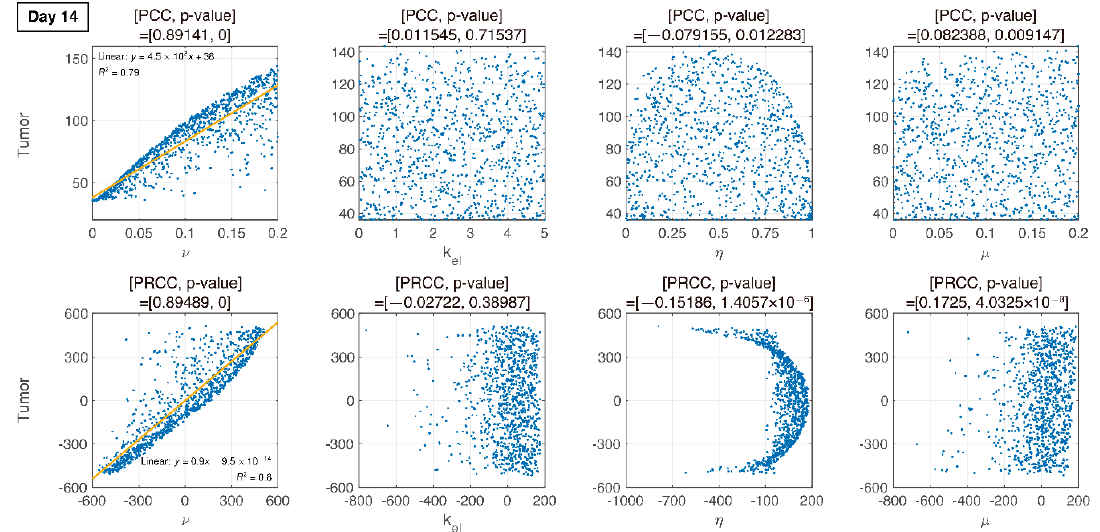
Figure 7. Dotted points indicate tumor size on day 14. Combination therapy begins on day 14. An increase in 𝜈 is proportional to tumor growth with PRCC and p-value. Other parameters are less influential.